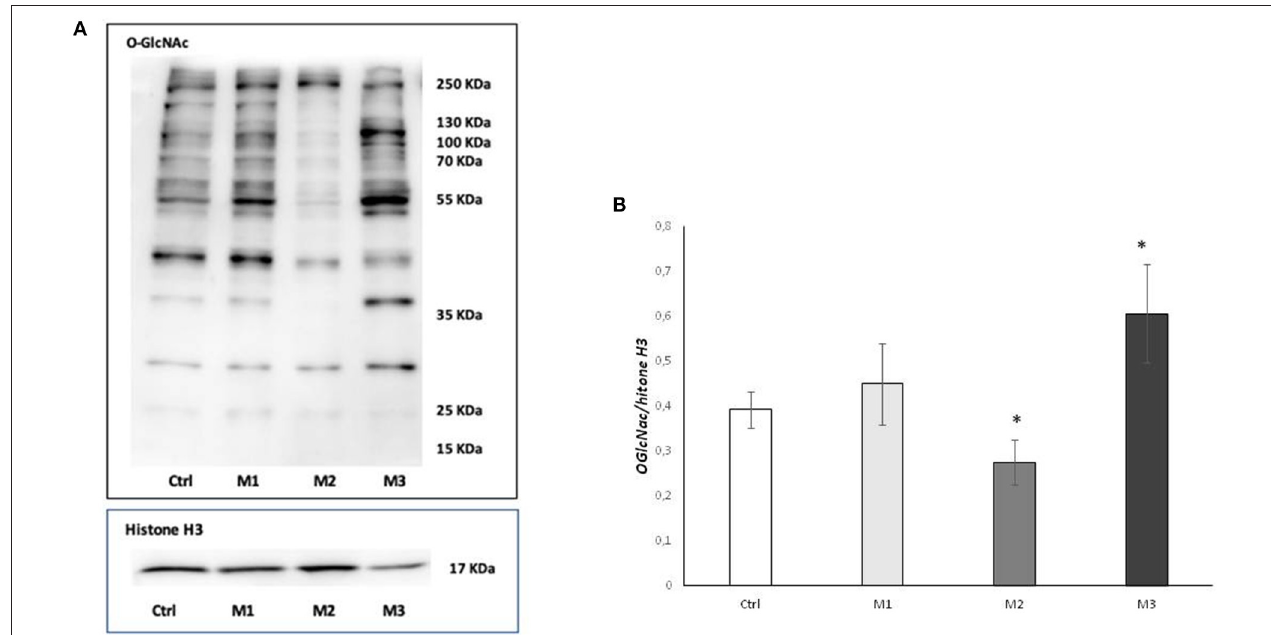
FIGURE 1 | Total O-GlcNAcylations after exposure to M1, M2, and M3 wear debris. (A) O-GlcNAcylations of cell proteins examined by western blotting. The western blot image is representative of three experiments. (B) Densitometric analysis of proteins expression was performed using Histone H3 as loading control. * P < 0.05 vs. Ctrl. Materials M1, M2, M3 are described in the Methods section, as follows: Material M1a moderately cross-linked vitamin E-blended UHMWPE, EtO sterilized; Material M2 standard UHMWPE (without vitamin E and not cross-linked), EtO sterilized; Material M3 vitamin E-blended UHMWPE not cross-linked, EtO sterilized. Cnotrol (white bar) Material M1 (light gray bar), material M2 (medium gray bar), material M3 (dark gray